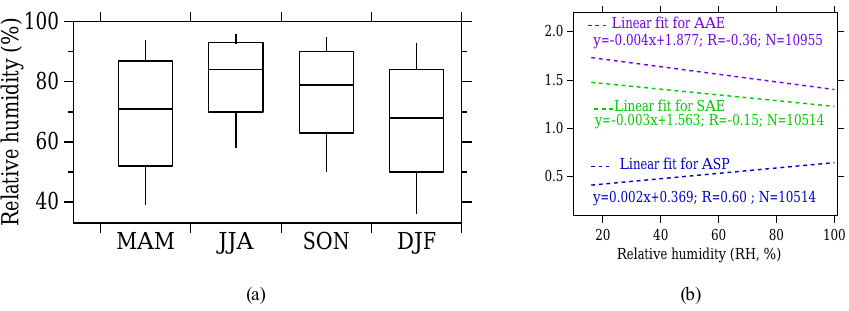
Figure 9. Seasonal variations of RH ( a , %) and linear correlations between AAE and RH ( b , light blue, upper), between SAE and RH ( b , green, middle) and between ASP and RH ( b , deep blue, lower).